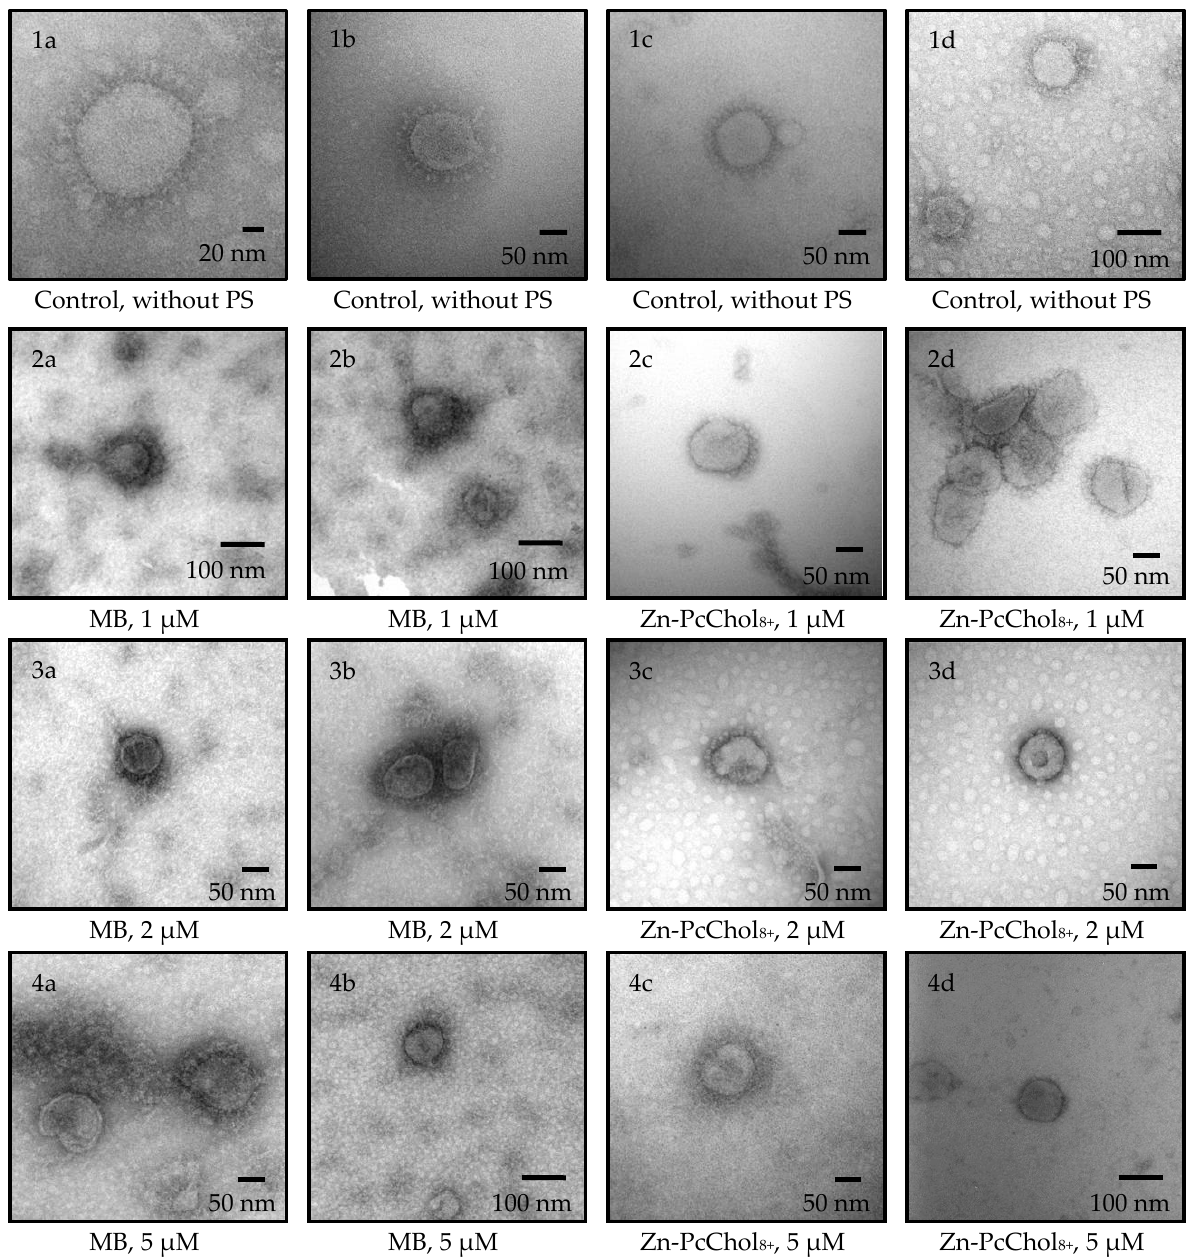
Figure 2. Electron micrographs of BCoV negatively stained with 2% uranyl acetate after 10 min incubation in the dark without PS (control), or with different concentrations of MB or Zn-PcChol 8+ . Recently, we showed that both dyes, monocationic MB and octacationic Zn-PcChol 8+ , possess an affinity for negatively charged regions of coronavirus spikes, the main region of which is located at the connection of the S-protein stalk and the head on the linker between the HR1 and HR2 domains, adjacent to HR2 [22]. Incubation of BCoV for 10